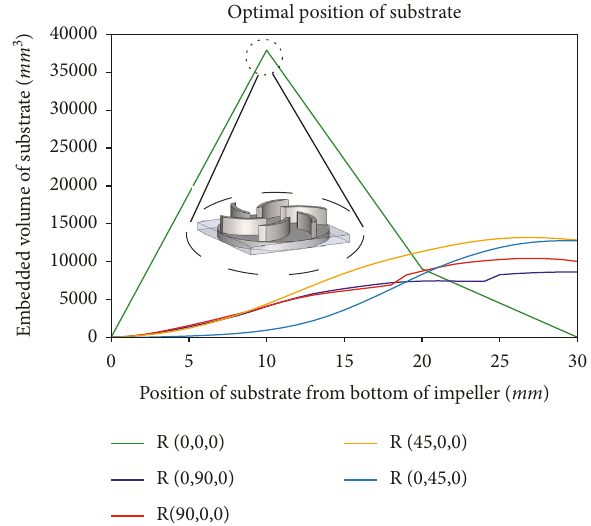
Figure 20: Variation of VI between the substrate and the impeller for different orientations.